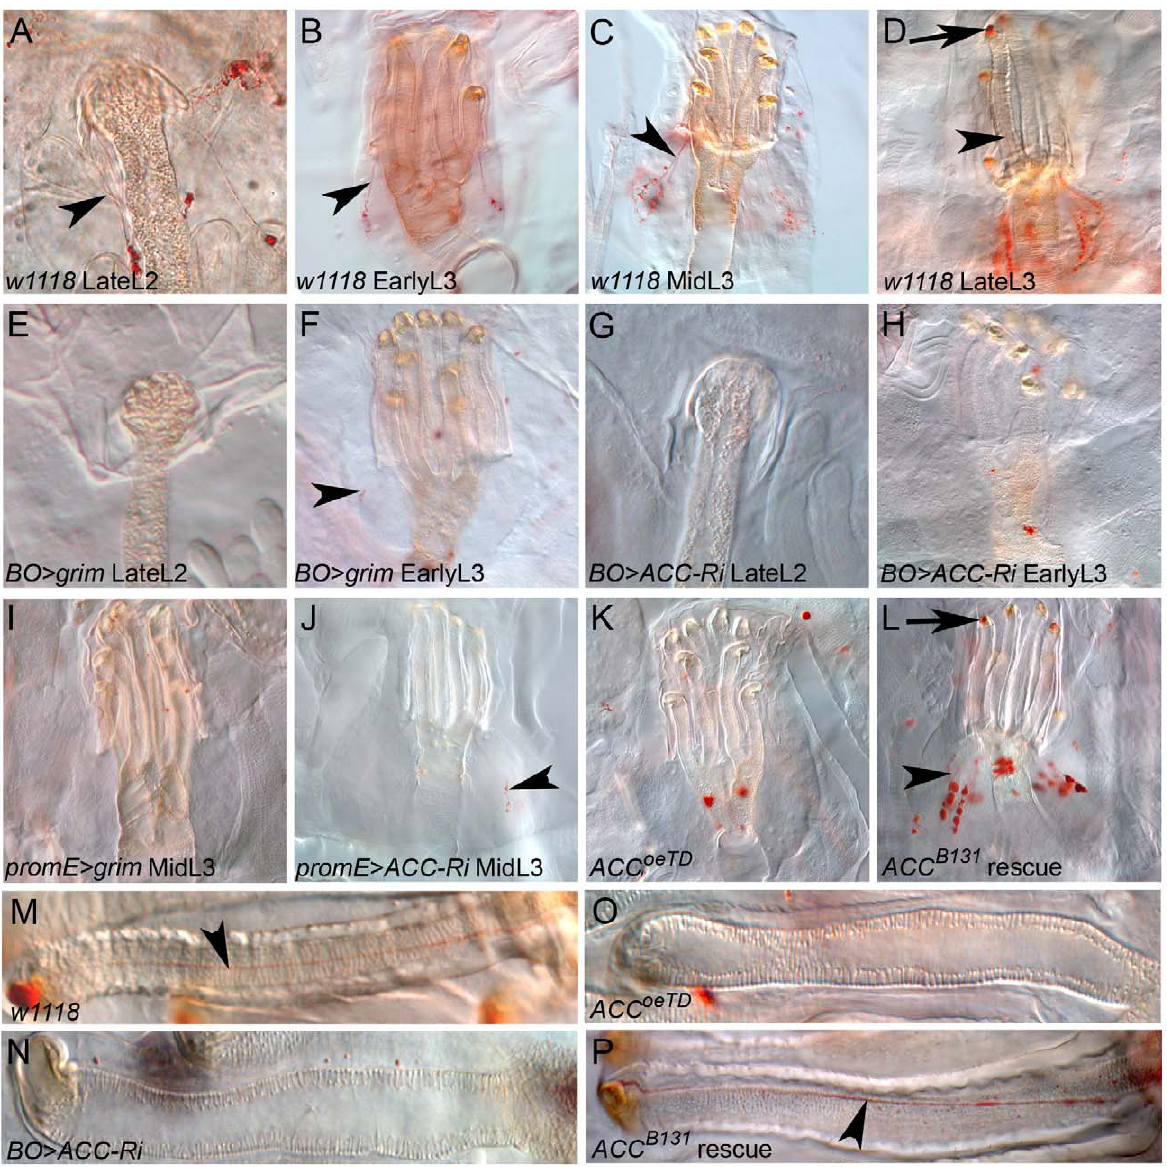
Figure 6. Lipid transfer within the anterior spiracles. (A–P) Oil-Red-O staining of anterior spiracles. (A–D) Control larvae at the late L2 (A), early L3 (B), mid L3 (C), late L3 (D) stages contain LD clusters in their spiracular glands that form lipid-containing ducts (arrowheads); note the accumulation of lipids at the spiracular opening of late L3 larvae (arrow in D). (F–L) Spiracles at the late L2 stage (E,G) and after the L2/L3 molt (F,H,I,J,K,L) of the following larvae: (E–F) BO . grim , (G–H) BO . ACC-RNAi , (I) promE . grim , (J) promE . ACC-RNAi , (K) ACC oeTD and (L) ACC B131 mutant rescue. (M–P) Presence (M,P) or absence (N,O) of lipid-containing ducts in L3 spiracular terminal branch of the following larvae: (M) control, (N) BO . ACC-RNAi , (O) ACC oeTD ; (P) ACC B131 mutant